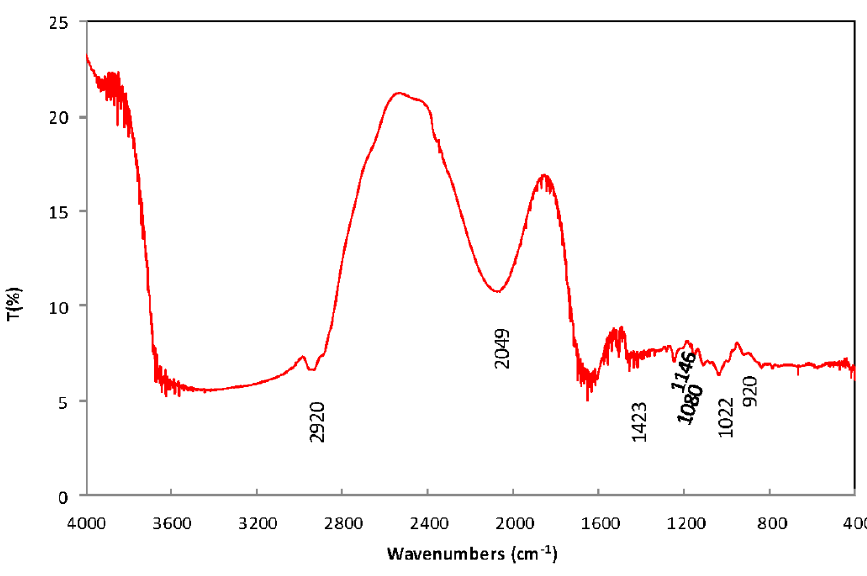
Fig. 4. IR spectrum of the TPS film